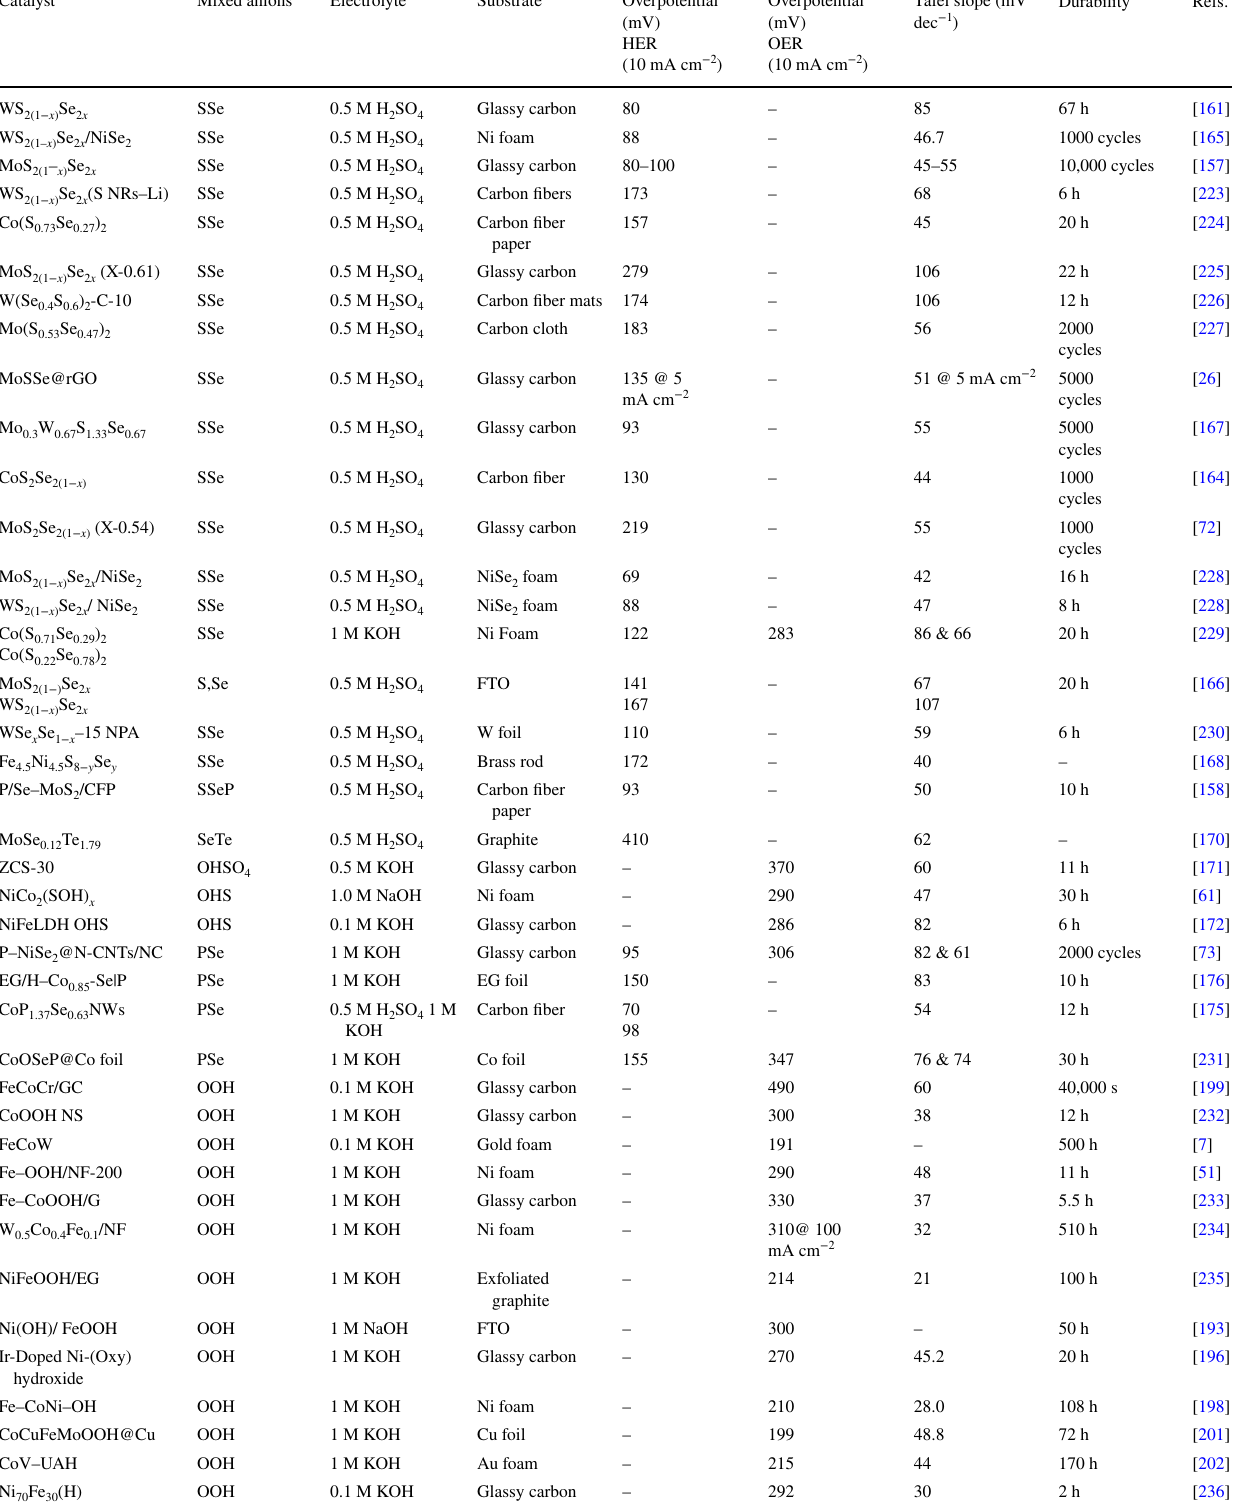
Table 3 Comparison of the OER and HER performance of typical mixed chalcogenides (sulfoselenides, selenotellurides, hydroxy (sulfates, sulfides), and phosphoselenides), (oxy)hydroxides, and borides/borates electrocatalysts